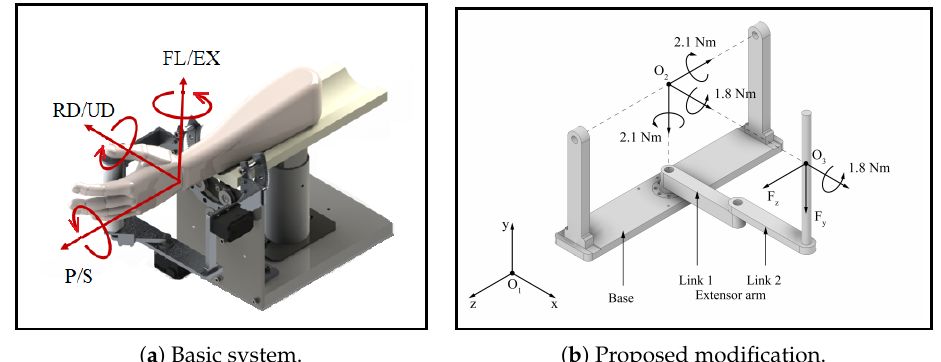
Figure 1. Wrist rehabilitation